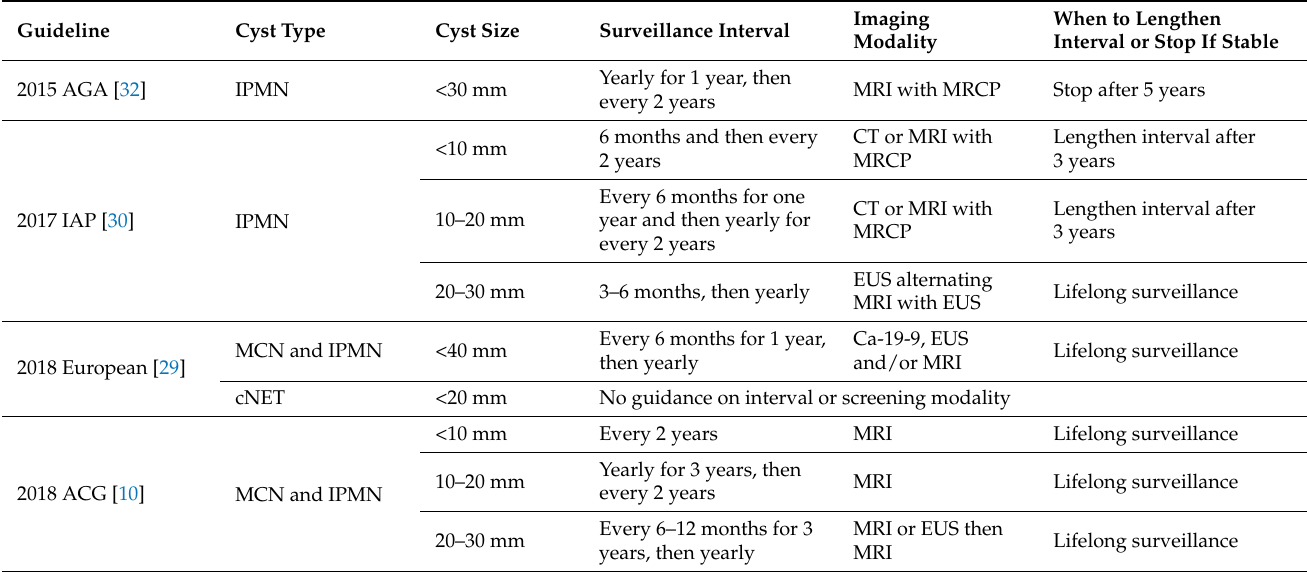
Table 4. Imaging Surveillance Interval of Non-Resected Pancreatic